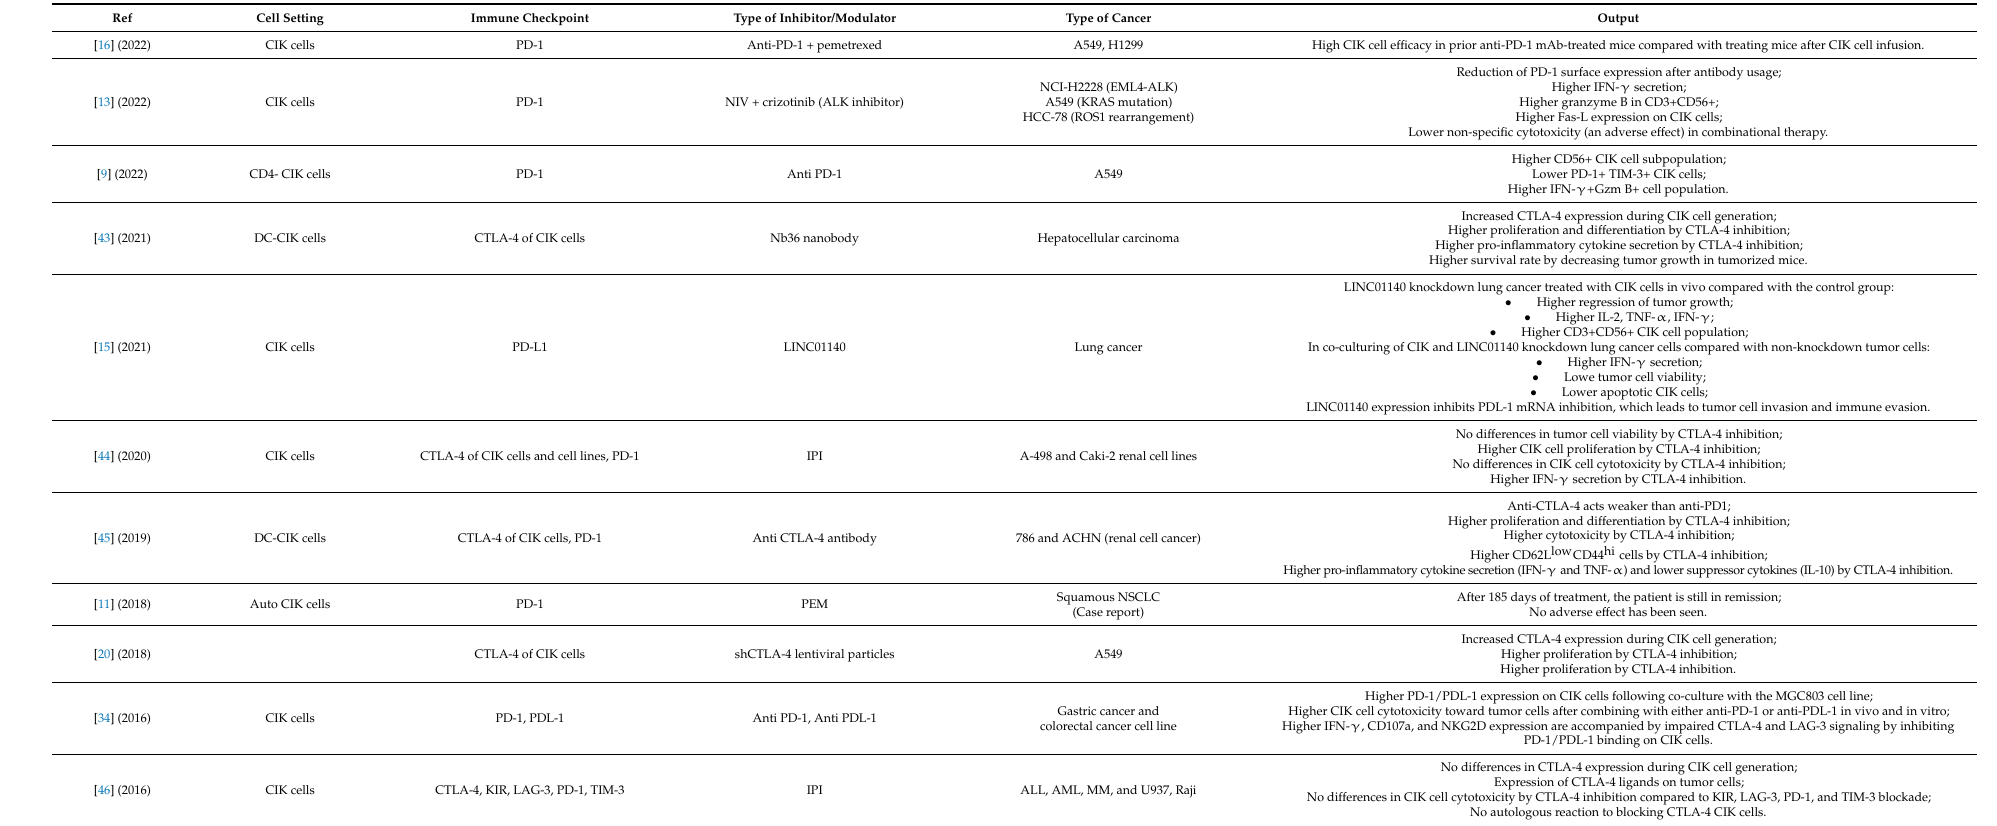
Table 2. Pre-clinical and case studies regarding CIK cells and immune checkpoint